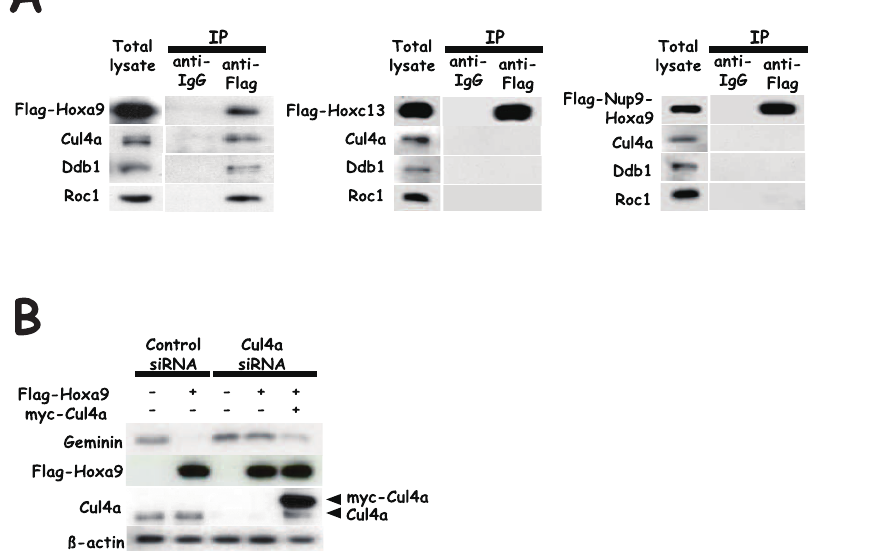
Figure 3. Immunoprecipitation analysis of Hox derivatives and effect of Cul4a knock-down on Hoxa9-mediated down-regulation of Geminin protein in HEK-293 cells. ( A ) Either of Flag-Hoxa9, Flag-Hoxc13 or Flag-Nup98-Hoxa9 was transfected in HEK-293 cells, and the complex formation with endogenous Cul4a, Ddb1 and Roc1 was examined by means of immunoprecipitation analysis using an anti-Flag antibody. ( B ) Cul4a siRNA was transfected, and the effect on Hoxa9-mediated down-regulation of Geminin protein was examined. Down-regulation of Cul4a by siRNA was confirmed by immunoblot analysis, and the level was restored by transfection of myc-tagged Cul4a. Endogenous Cul4a was also detected in myc-tagged Cul4a-transfected cells even if cells were pre-treated with siRNA for Cul4a probably because exogenously overexpressed mRNA for Cul4a prevented siRNA from affecting endogenous Cul4a.